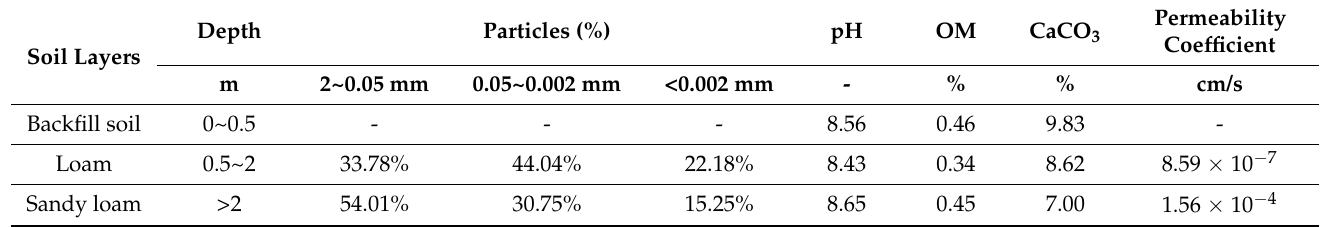
Table 2. The physicochemical properties of the soil layers at this chrome plating